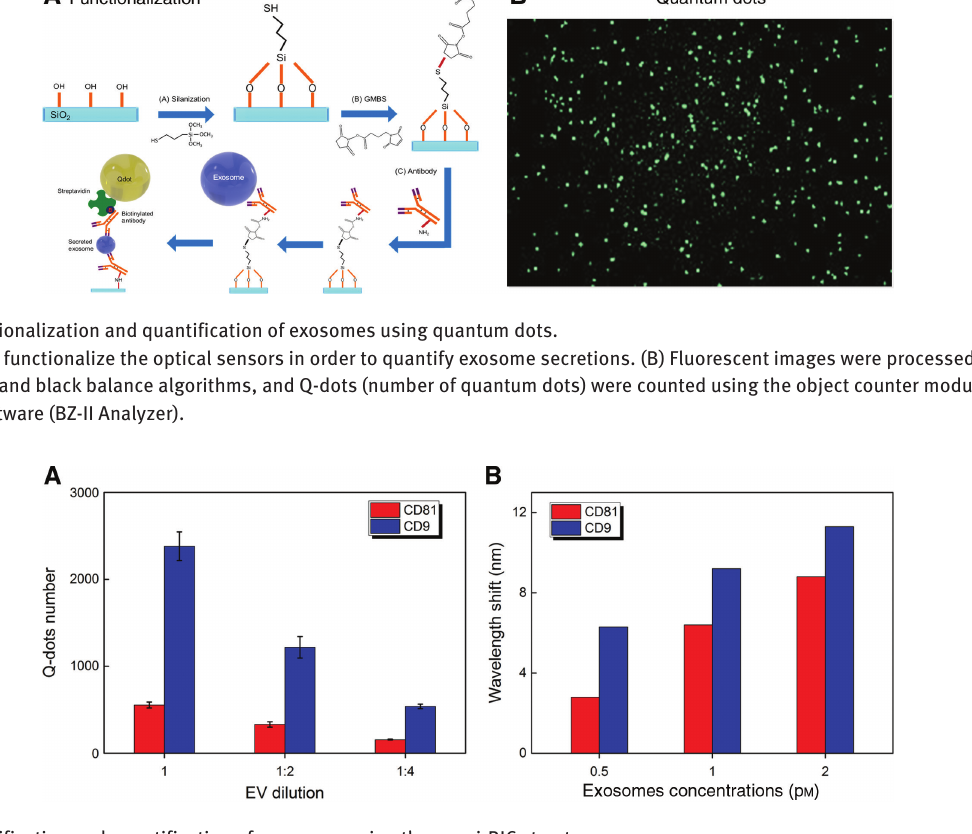
Figure 6: Identification and quantification of exosomes using the quasi-BIC structure. (A) Number of Q-dots (counted by the object counter module in the microscope software) as a function of the EV dilution. (B) Exosome concentration for both CD81 and CD9 as a function of the wavelength shift, evidencing that the quantity of CD9 is higher than that of CD81 for the